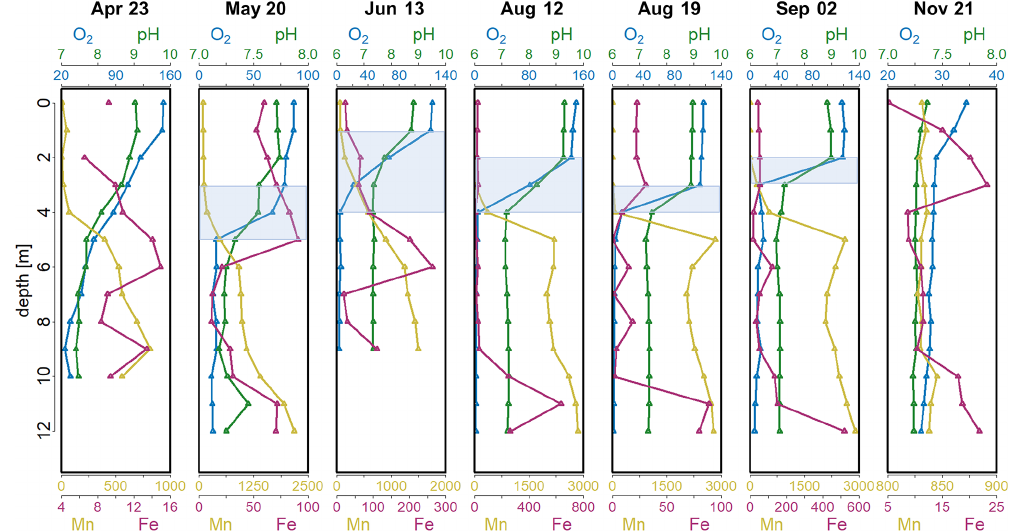
Figure 1. Depth profiles of O 2 saturation (%), pH and concentrations of dissolved Mn (µgL − 1 ) and Fe (µgL − 1 ) in the Lake Ölper water column from April to November 2019. The depth of the sharp decrease in O 2 concentration and the start of Mn reduction (RTZ) are shown in each panel (shaded light blue). Note that each column has an individual scale to better illustrate changes with depth. Depth profiles with the same scale in all columns are shown in the Supplement (Fig.